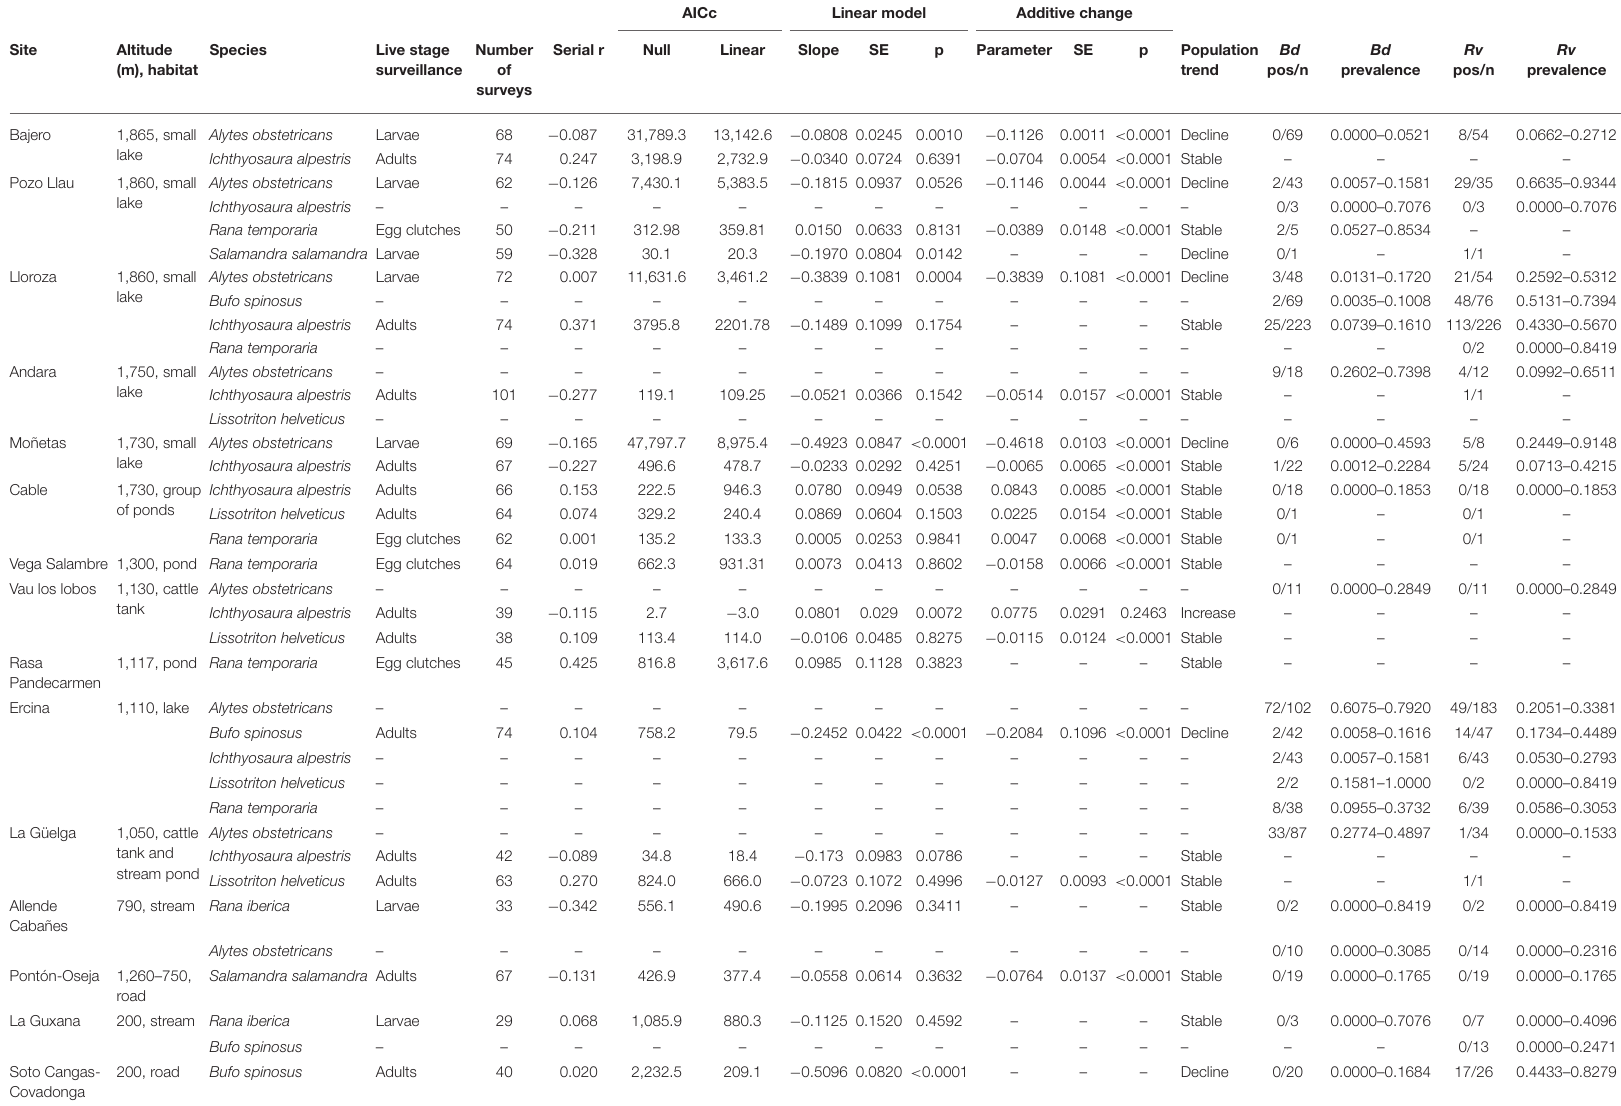
TABLE 1 | Results of TRIM models analyzing count data generated in 24 amphibian populations located at 15 sites during a 14 year